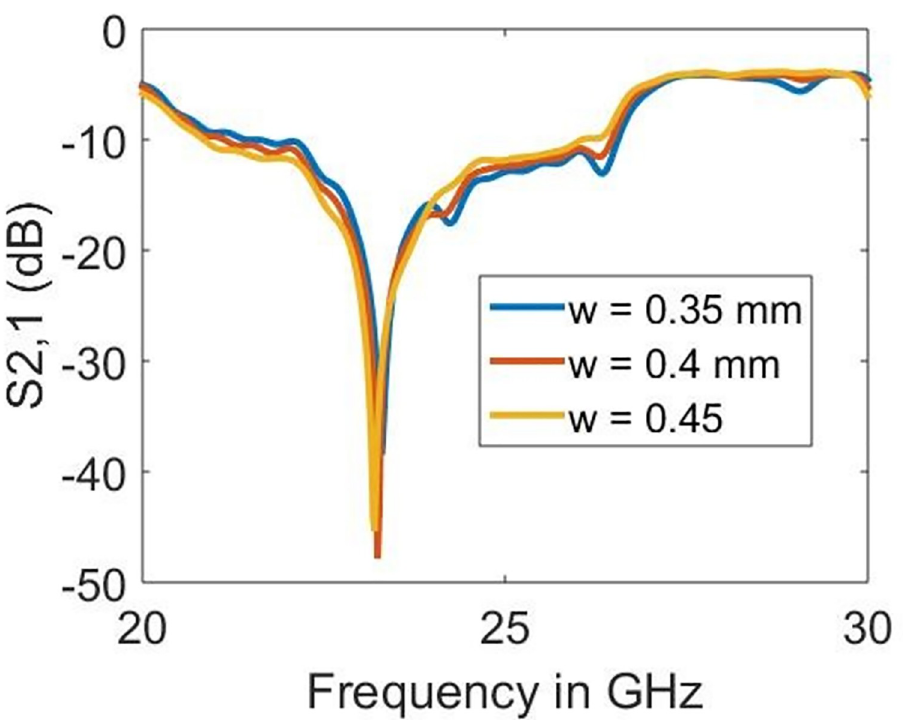
Fig 7. Effect of linewidth on the resonance frequency.